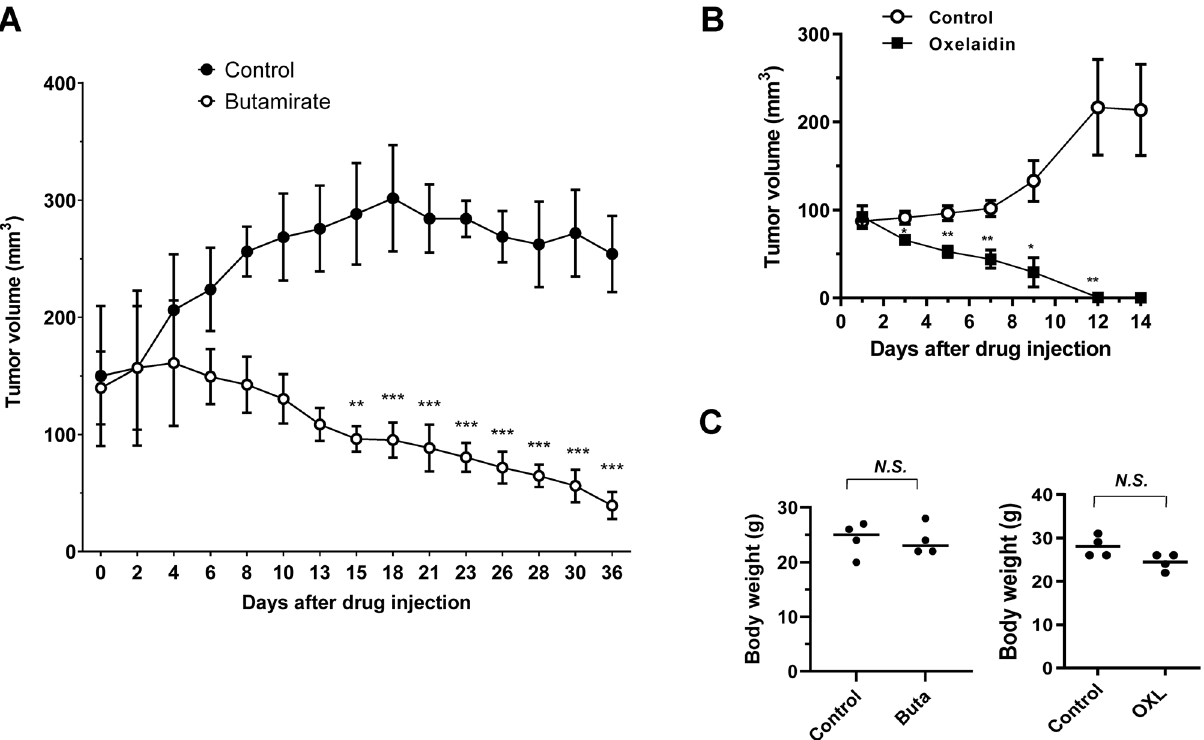
Figure 6. Effects of butamirate and oxelaidin on in vivo tumorigenesis of glioblastoma. ( A ) BALB/c nude mice were subcutaneously injected with U87MG cells and intraperitoneally administered 2 mg/kg butamirate or vehicle control for 36 days. ( B ) BALB/c nude mice were subcutaneously injected with U87MG cells and intraperitoneally administered 130 mg/kg oxelaidin or vehicle control for 14 days (5 days on, 2 days off). Tumor volumes were measured with a caliper every second day. Results are presented as means ± SEM. ( C ) Animal body weights were monitored 36 days (butamirate) or 14 days (oxelaidin) after injection. Lines represent mean values for each group (n = 4; *P < 0.05 and **P < 0.01 vs. vehicle , t- test). N.S., not